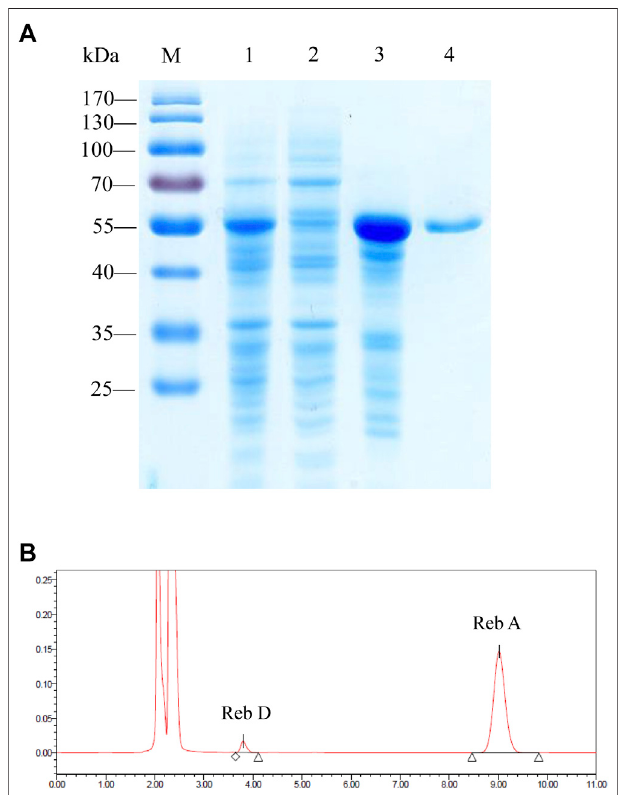
FIGURE 2 | (A) SDS-PAGE analysis of the proteins during the puri fi cation process of PgUGT. Lane M, protein molecular weight standards; lane 1, cell lysate; lane 2, supernatant; lane 3, pellet; and lane 4, puri fi ed enzyme. (B) HPLC detection of the application of PgUGT on Reb D